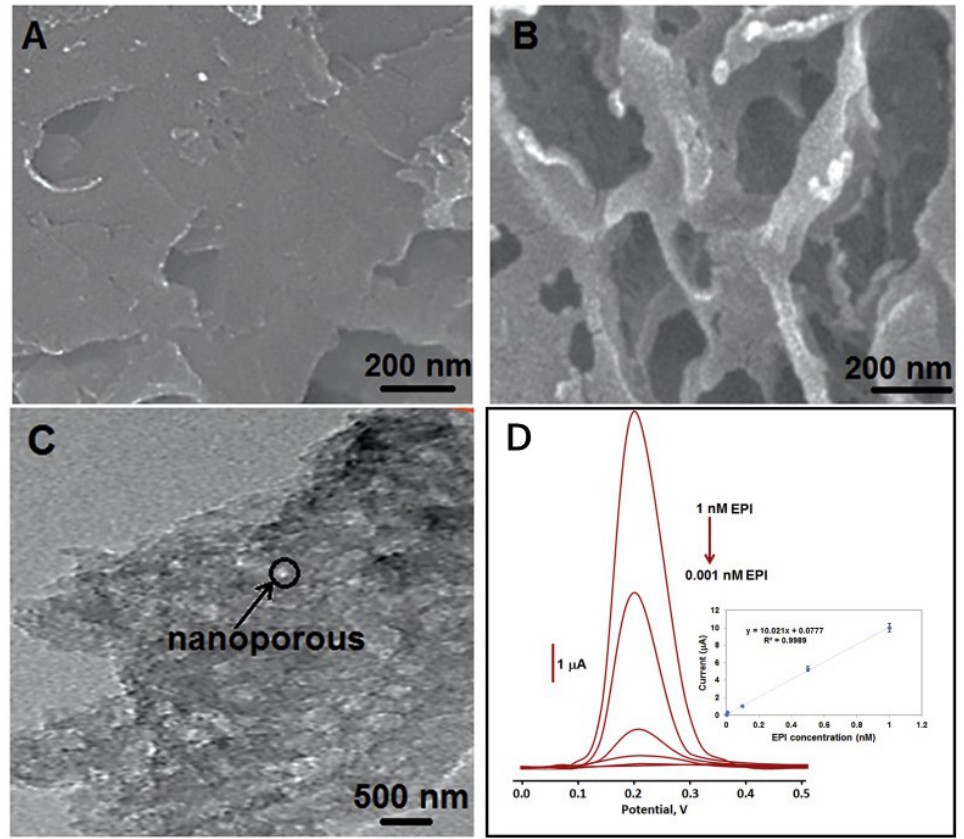
Figure 4. SEM image of ( A ) g-C3N4 ( B ) graphitic carbon nitride/N-doped carbon dots composite (g-C 3 N 4 /NCDS) (x) (x: 8.0% NCD S ( C ) TEM image of g-C 3 N 4 /NCD S (x) (x: 8.0% NCDS ( D ) Detection of EPI with different concentration on the current signals with DPVs: Inset: Calibration curve of EPI concentrations at MIP/g-C3N4/NCD S (8.0%)/GCE in pH 7.5 of PBS (from 1.0 × 10 − 12 to 1.0 × 10 − 9 M). (Reproduced with permission from ref. [100]).